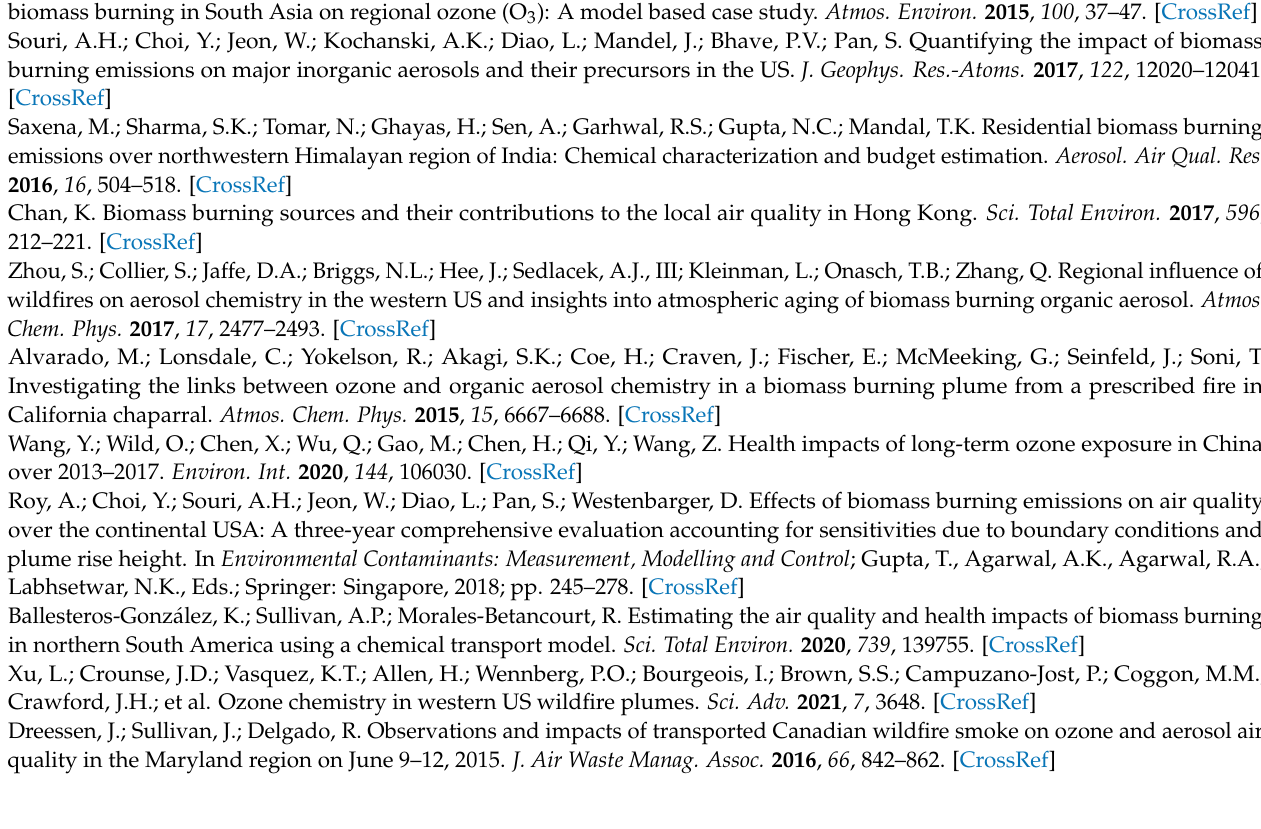
Figure S1. (a) The average vertical profile of emis-sions for each method, and (b) the time variation of the PBL altitude used in the FINN_pbl method during the period of wildfire; Figure S2. Spatial distribution of observation and CMAQ numerical simulation results of CO and O3 concentrations in D02. The values are averaged from April 20 to 30, 2020; Figure S3: Comparison of observed meteorological variables ((a) tempera-ture, (b) wind speed, (c) U-component, (d) V-component) by rawinsonde and results of WRF numerical simulations from 20 to 30 April